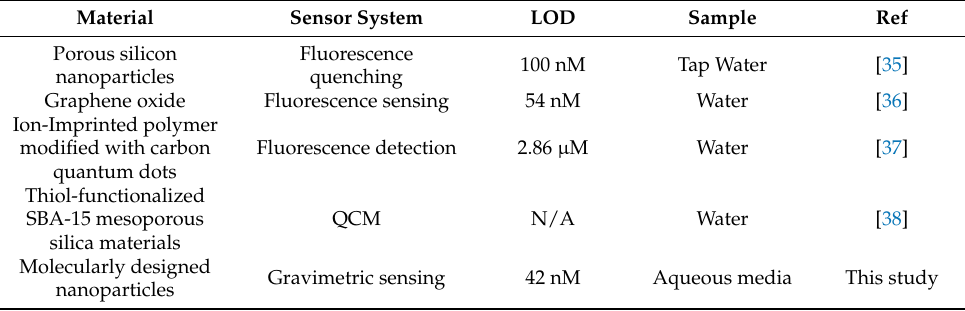
Table 6. Comparison of Cu(II) detection with various reported sensors.